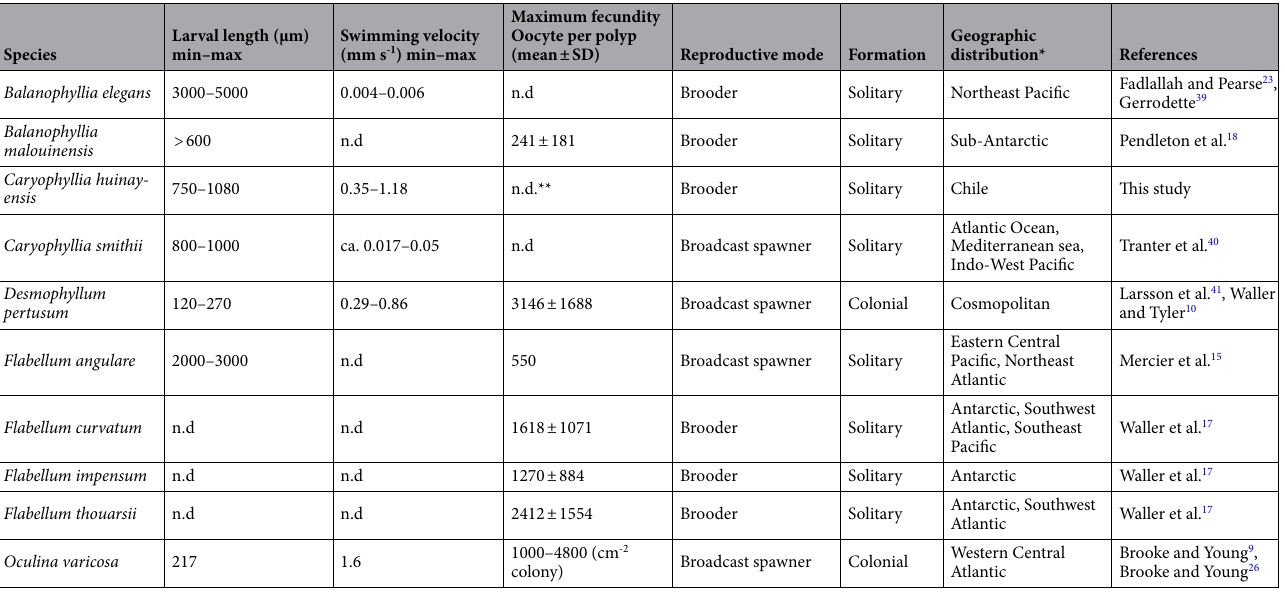
Table 1. Larval features of scleractinian CWC species. n.d. = no data. *According to Palomares and Pauly 42